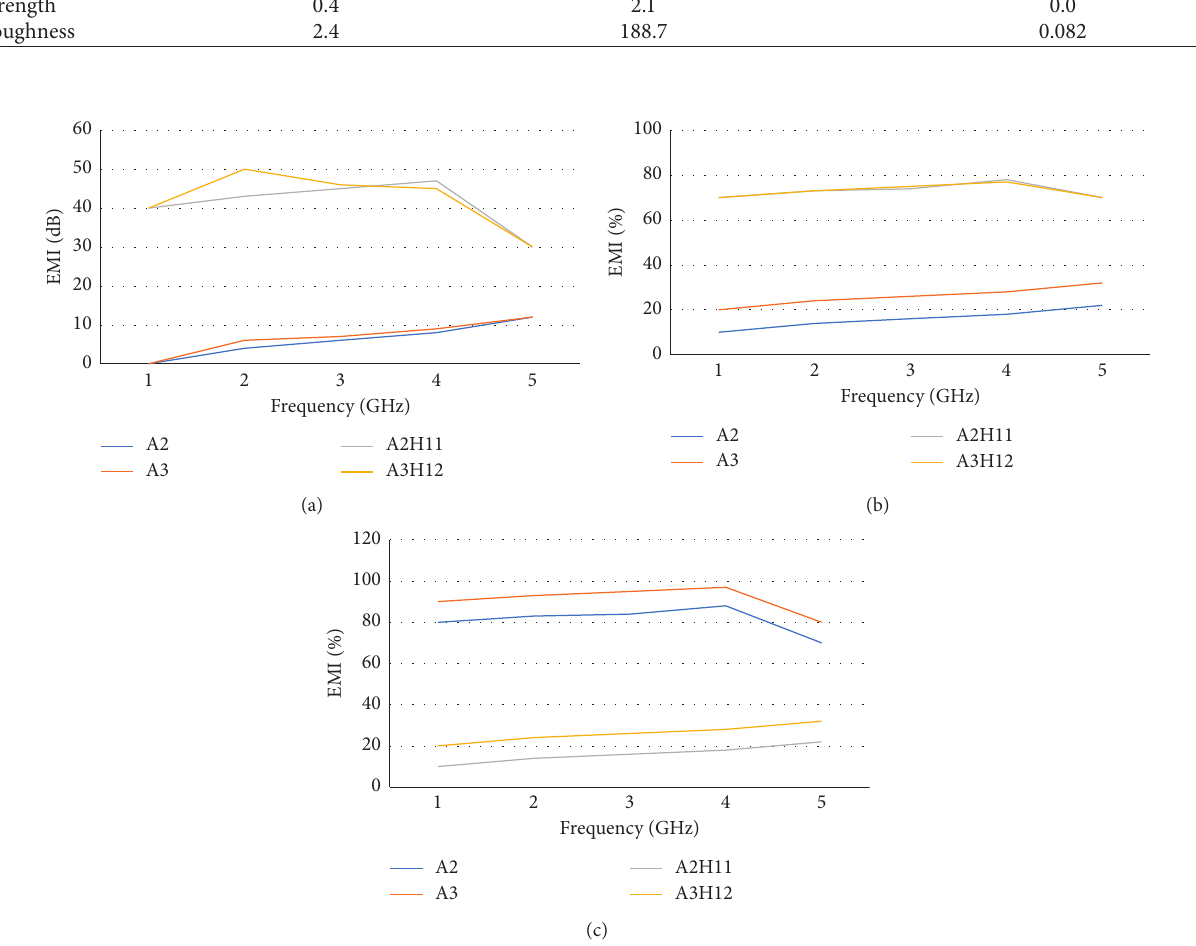
Figure 13: The shielding effectiveness of electromagnetic interference of the A2, A3, A3H11, and A2H12 composites. (a) Reflection contribution, (b) absorption, and (c) shielding